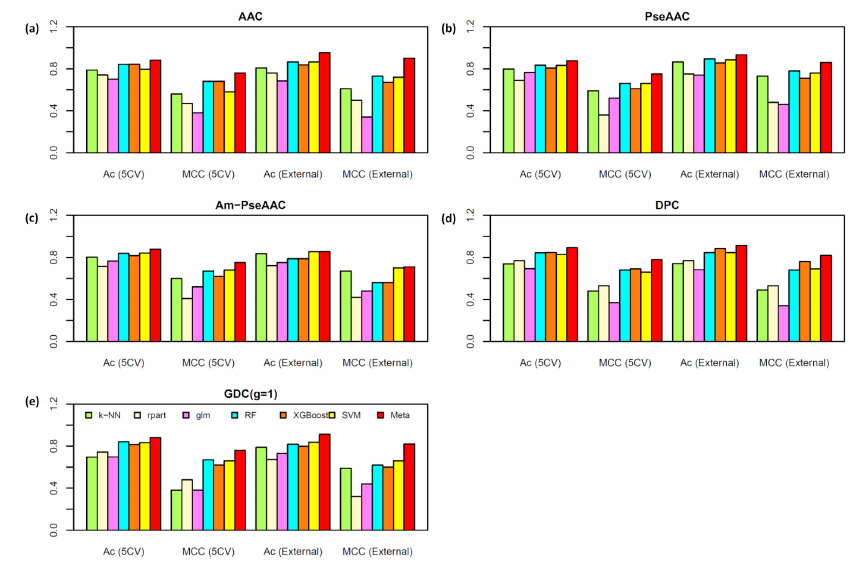
Figure 4. Performance comparisons of AVP predictors based on different six machine learning algorithms types of features, i.e., AAC ( a ), PseAAC ( b ), Am-PseAAC ( c ), DPC ( d ), and GDC ( e ), on the dataset T 544p + 407n + V 60p + 45n , respectively.